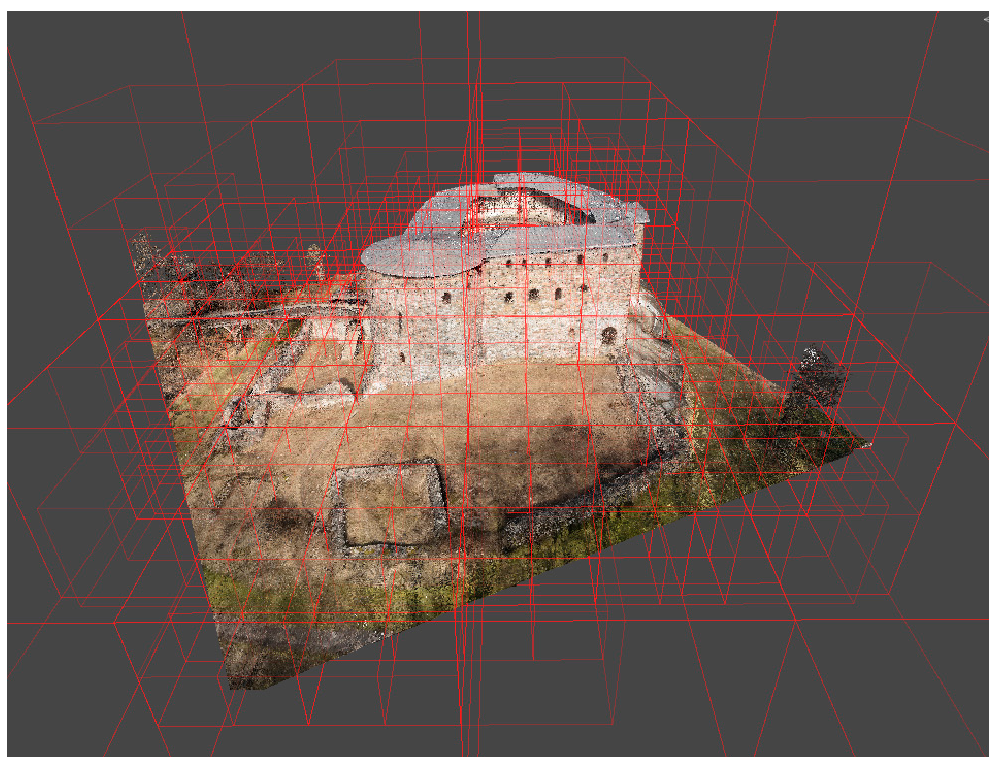
Figure 3. A game engine based visualization of a dense point cloud showing (in red) the octree structure used.